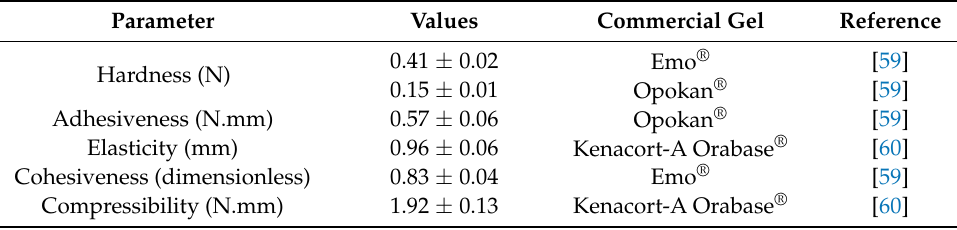
Table 4. The mechanical properties of commercial gel formulations. Parameter Values Commercial Gel Reference